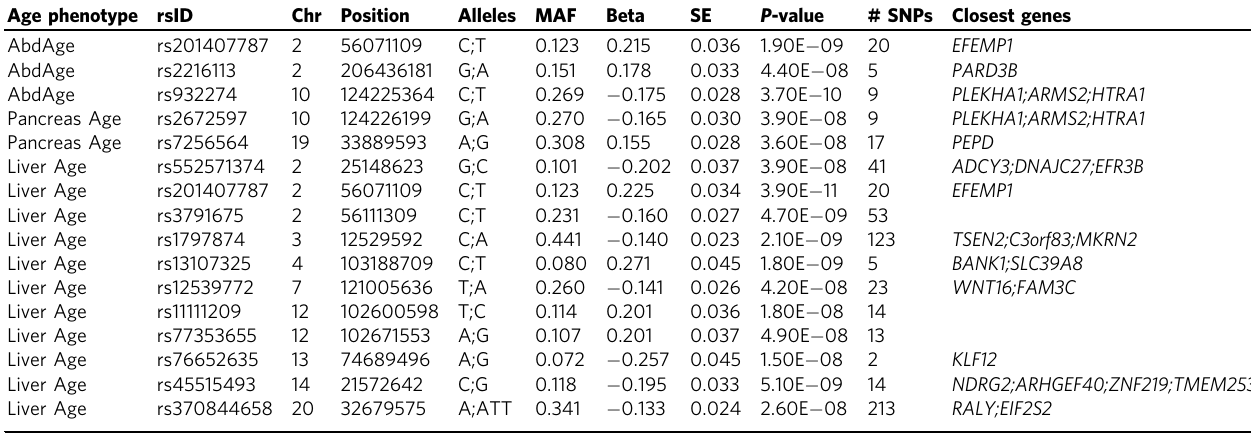
Table 1 Genome-wide signi fi cant loci implicated in accelerated Abdomen Age (AbdAge), Pancreas Age, and Liver